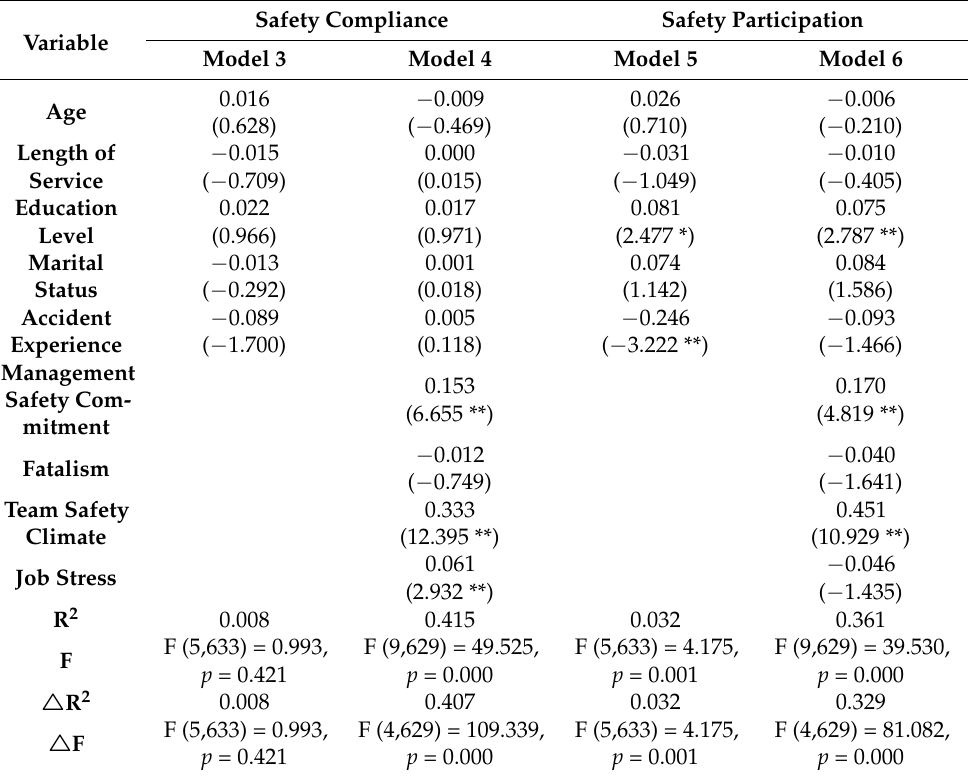
Table 15. Regression analysis of the impact of safety attitude dimensions on safety participation and safety compliance (N = 639).